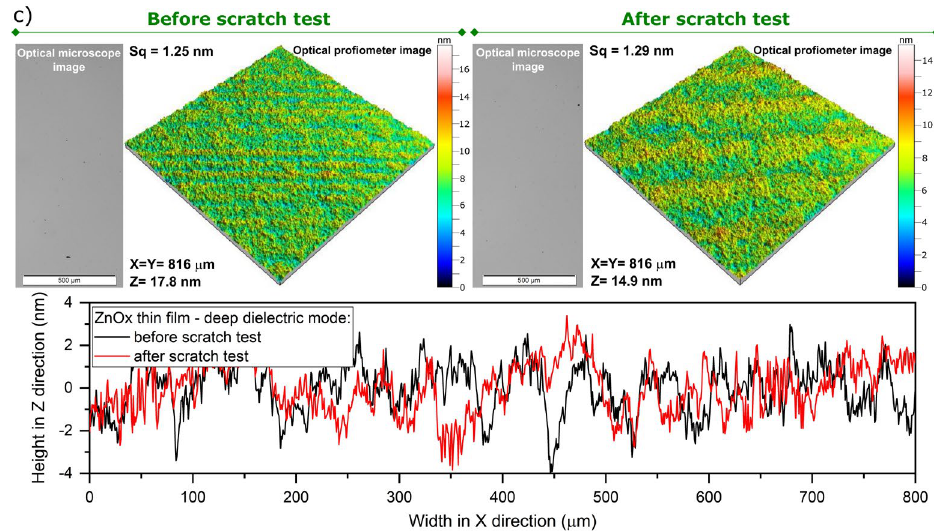
Figure 12. Optical microscope and profilometer images and surface cross-sectional profiles of ZnOx thin films deposited in various sputtering modes: ( a ) metallic, ( b ) shallow dielectric and ( c ) deep dielectric before and after performing abrasion tests.